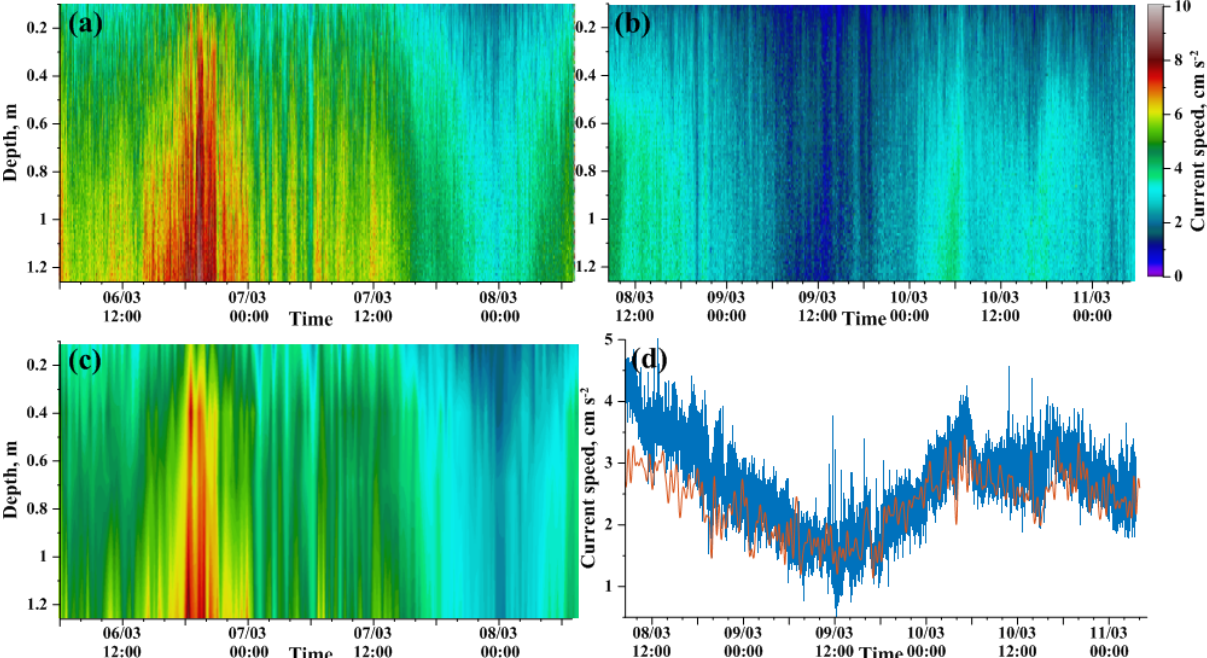
Figure 5. Horizontal current speeds at station S1 (a, c) and station S2 (b, d) measured by the acoustic Doppler profiler Aquadopp (a, b) and the electromagnetic loggers INFINITY (c) . (a) – (c) are the time–depth maps; (d) shows the horizontal flow speed measured by a single INFINITY logger at 1m under ice (thin red line) and the Aquadopp velocity record from the same depth (thick blue line).